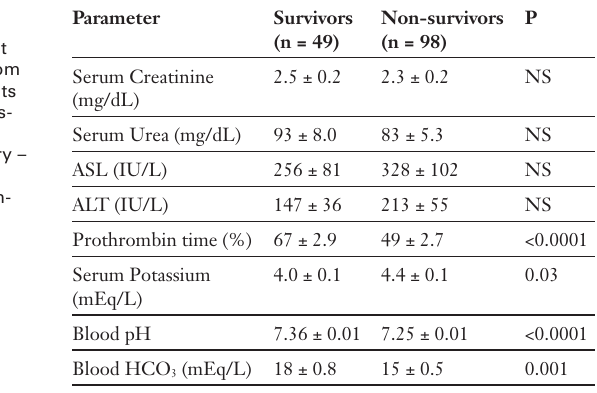
laboratory data at ICU admission from critically ill patients with infectious dis- ease-associated acute kidney injury – comparison of survivors and non- survivors.